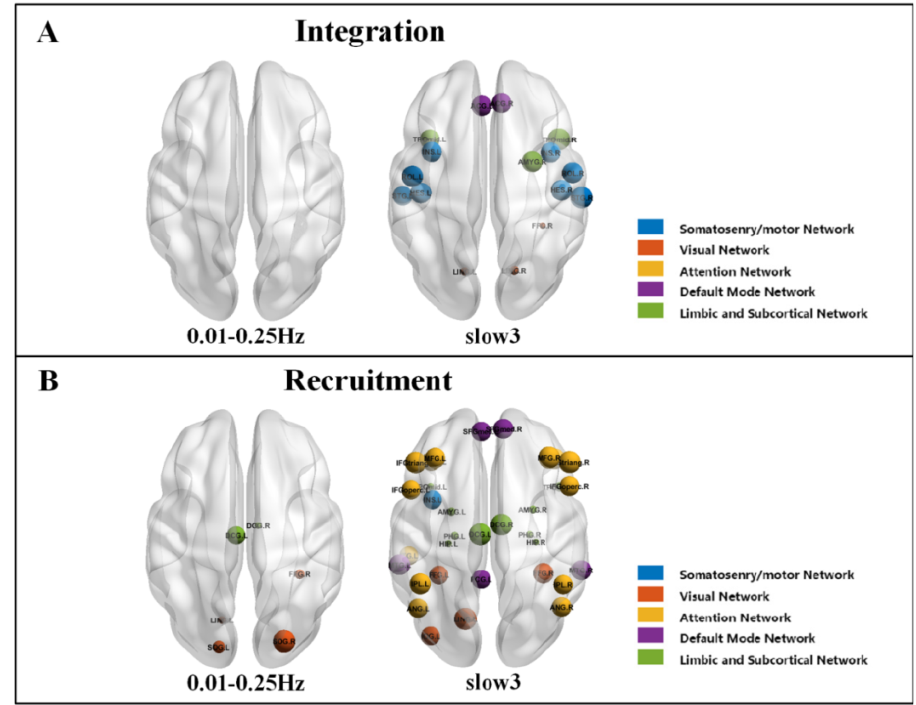
Figure 6. Difference between the NC and SZ in node vulnerability at full frequency (0.01–0.25 Hz) and slow3 (0.073–0.198 Hz). ( A ) Integration. ( B ) Recruitment. Table 6. Brain map of regions with significant differences on integration in slow3 (0.073–0.198